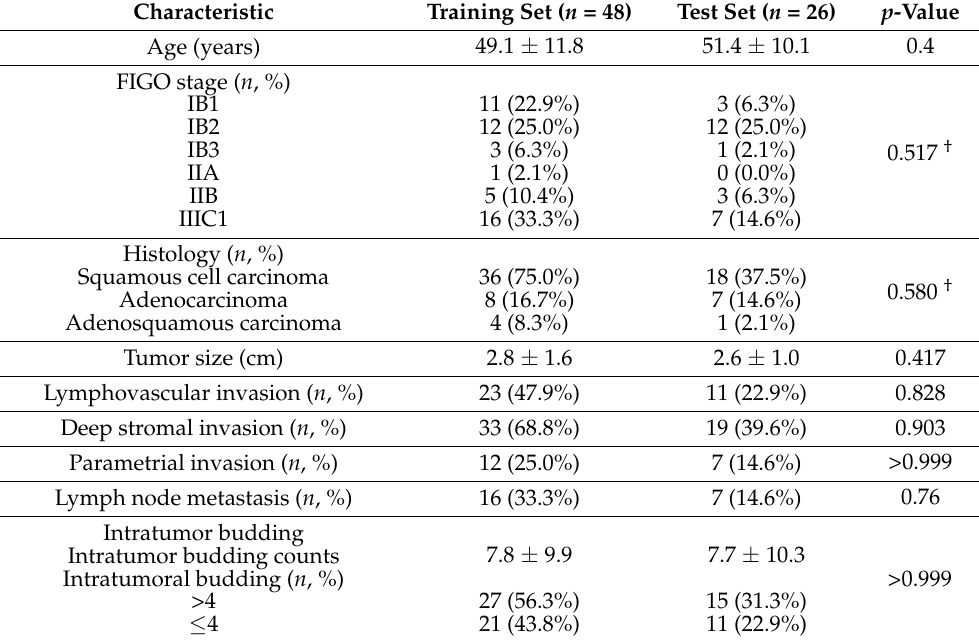
Table 1. Clinicopathologic characteristics of the 74 patients.